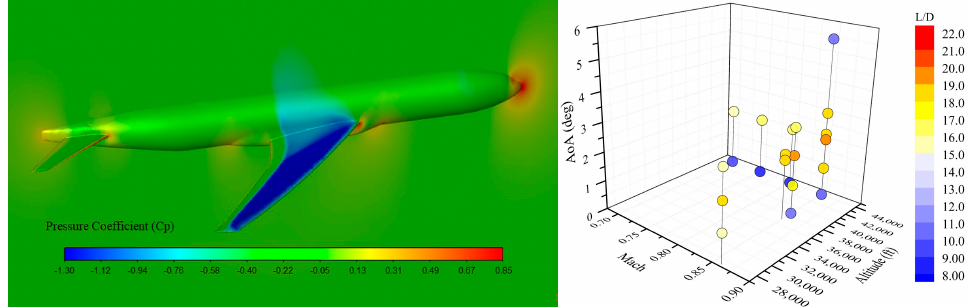
Figure 6. CRM aircraft in various flight conditions. ( Left ): Steady pressure (C p coefficient) on and around the aircraft in cruise flight conditions S 1 (M = 0.85 at 44,000 ft) with an angle-of-attack α = 5.5°. ( Right ): L/D values obtained for the various flight conditions and aerodynamic settings ( α ).